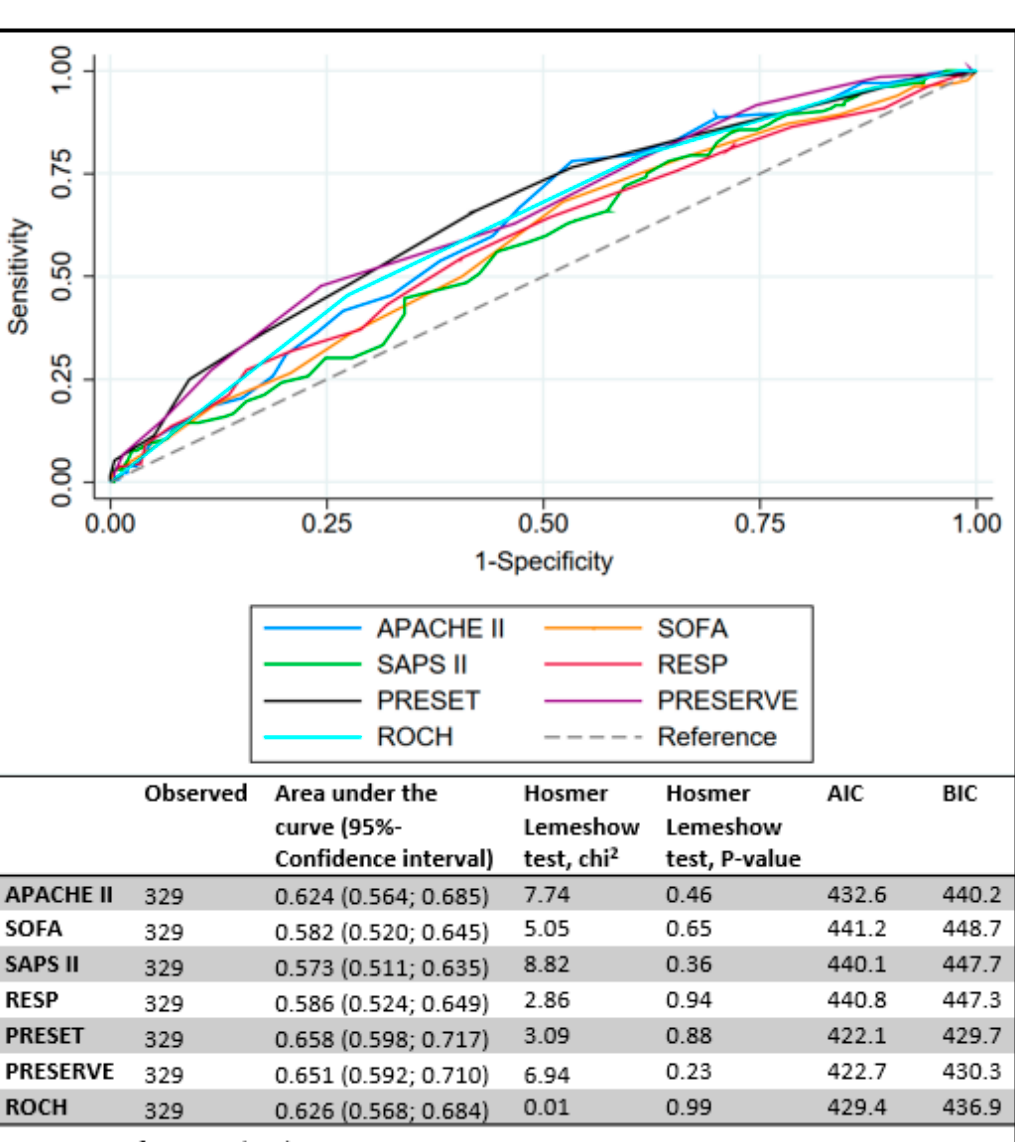
Figure 6. Comparison of area under the receiver-operating characteristics curve (AUC) for veno-venous extracorporeal membrane oxygenation scores. Akaike and Bayesian Information Criterions (AIC and BIC, respectively).